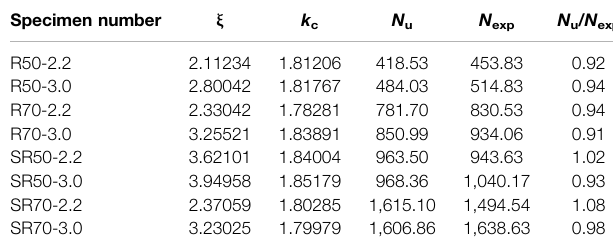
TABLE 3 | Comparison of calculated and test